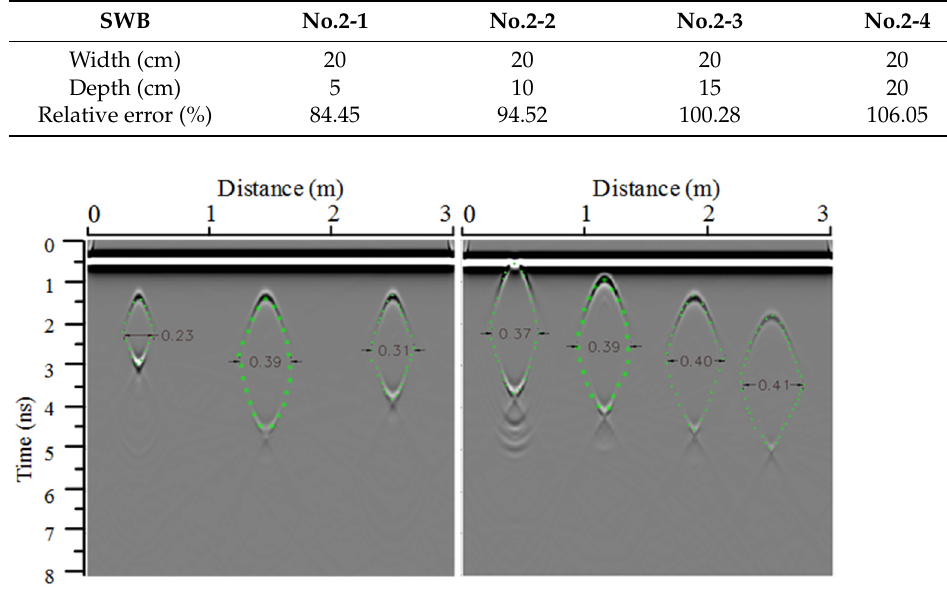
Figure 9. The SWB width from the FK migration radargrams of Figures 7a-1 and 8a-1. Unit: Meters.